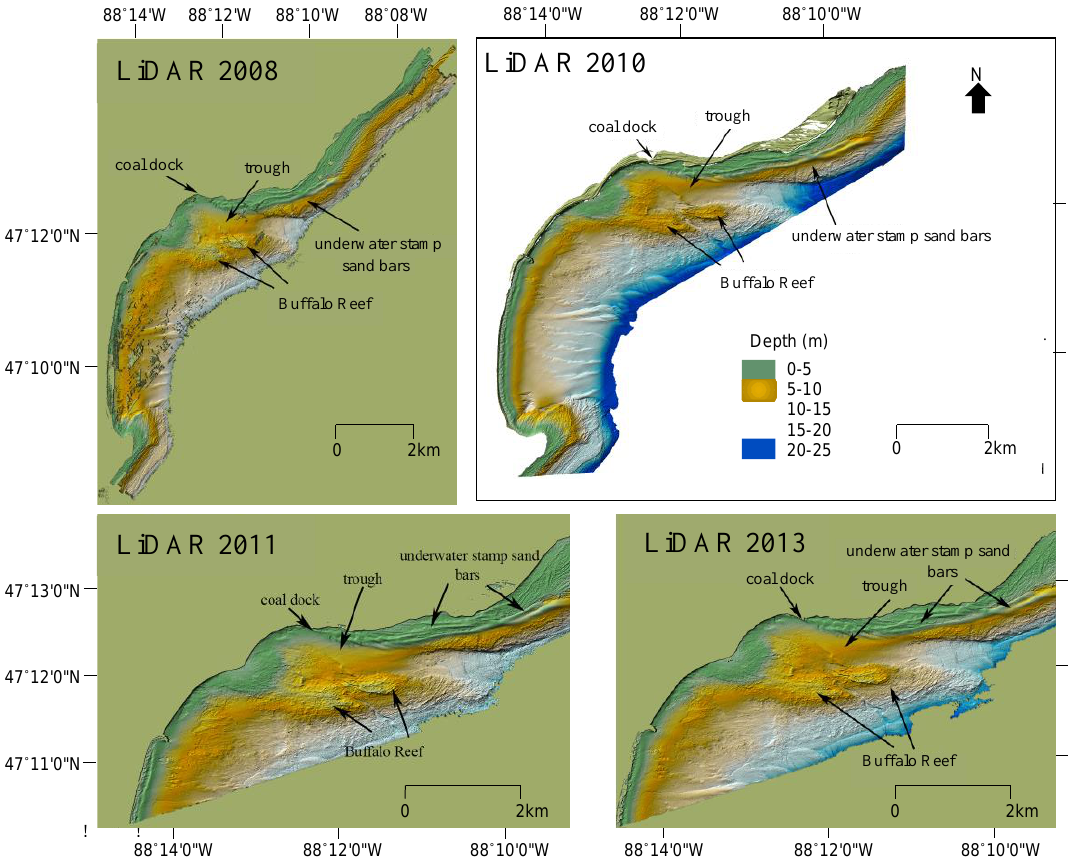
Figure 7. Four years of LiDAR DEMs (2008, 2010, 2011, 2013) for Grand Traverse Bay. The various DEMs are aligned, with similar depth color-coating at 5-m intervals (0–25 m depth). Notice LiDAR penetrates from 0–5 (green) down to 20 (light blue) and 23m (deep blue). Again, hill shade techniques enhance 3-D relief appearance.